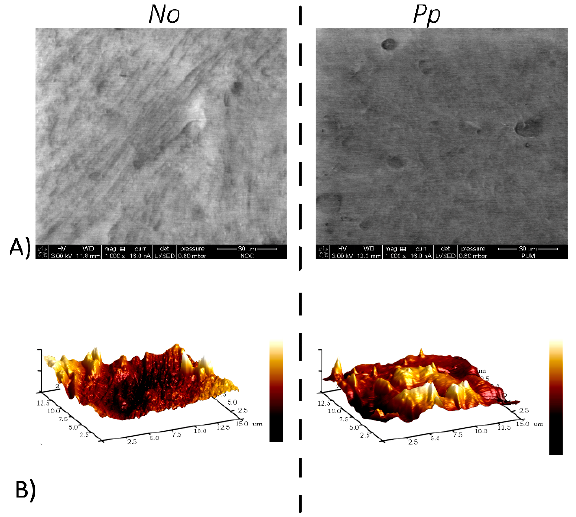
Figure 3. SEM ( A )* and atomic force microscopy ( B )* images of the biofilms. No: Nostoc sp.; Pp: Porphyridium purpureum . * indicates a selected image. n = 5.